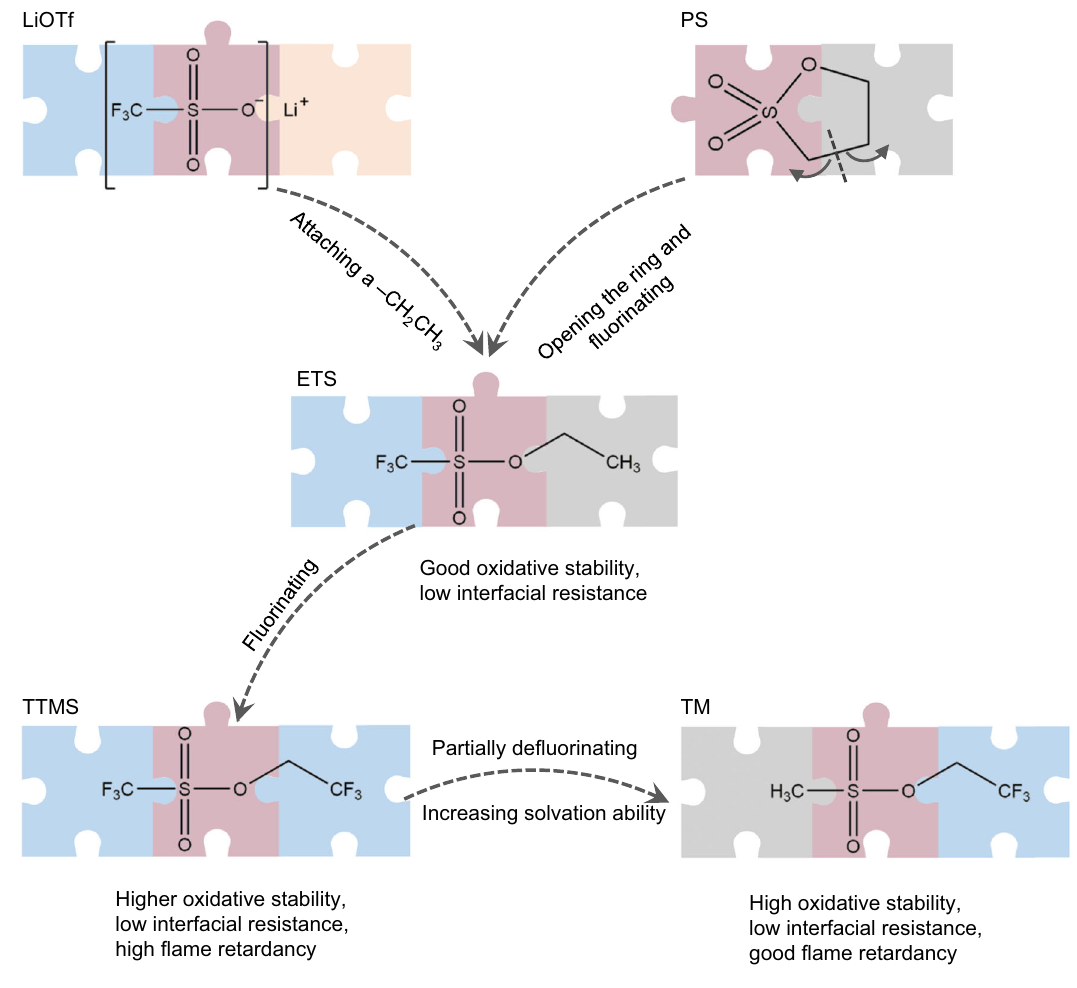
Fig. 1 | Design steps for multifunctional sulfonate-based solvents based on the stable LiOTf salt and the PS fi lm-forming additive. By incorporating the func- tional groups into the LiOTf and PS and partial fl uorination, TTMS and TM should